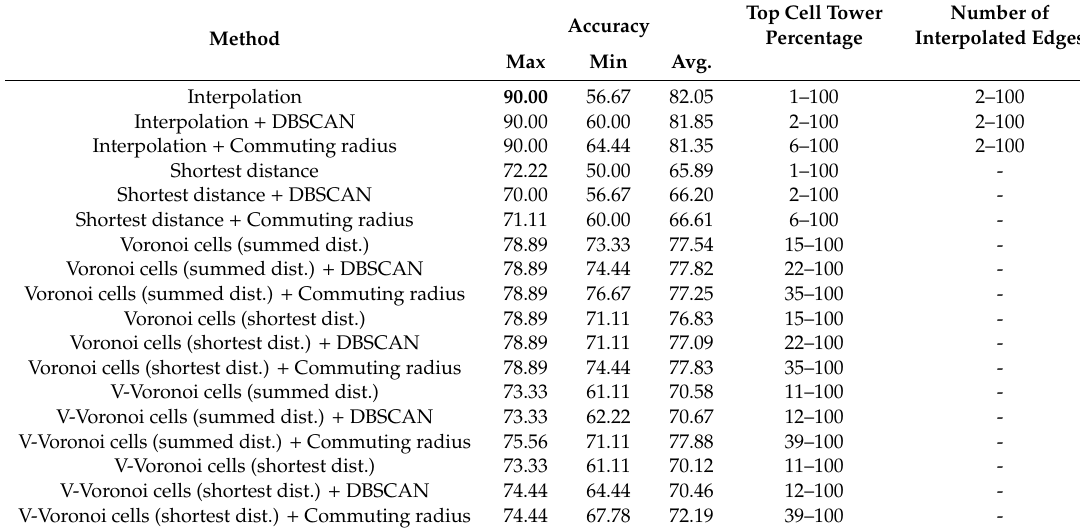
Table 1. Result summary of all proposed commuting route choice inference